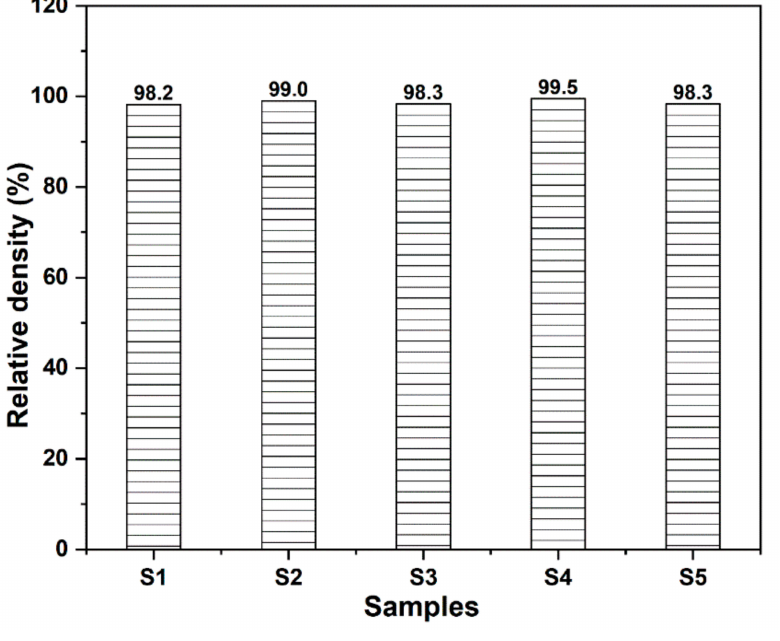
Figure 2. Relative density of the